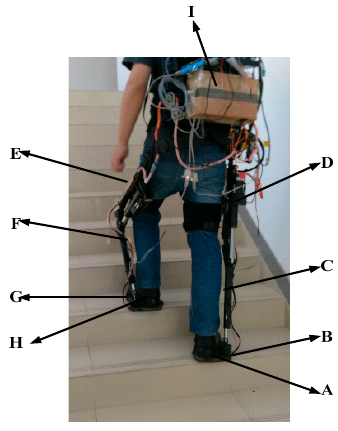
Figure 2. Mechanical structure of the robot used in this study. A and H : wearable shoes where three pressure sensors are placed in each; B and G : AHRS sensors which collect the inclination angles of foot for double legs; C and F : AHRS sensors which are attached to the leg segments to collect the inclination angles of shanks; D and E are motors with screws for the system; I : the central control system which collects data and produces control signals.